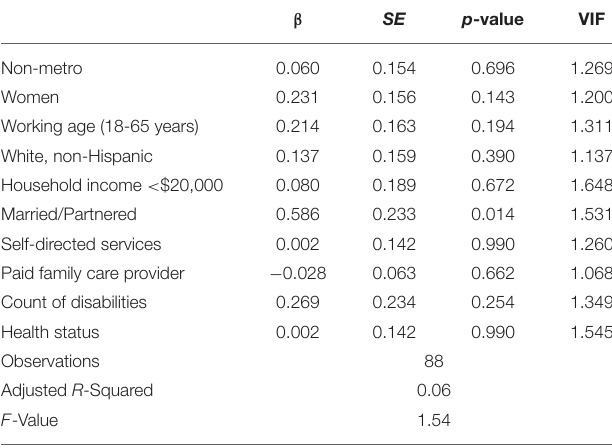
TABLE 2 | Linear regression predicting satisfaction with services.